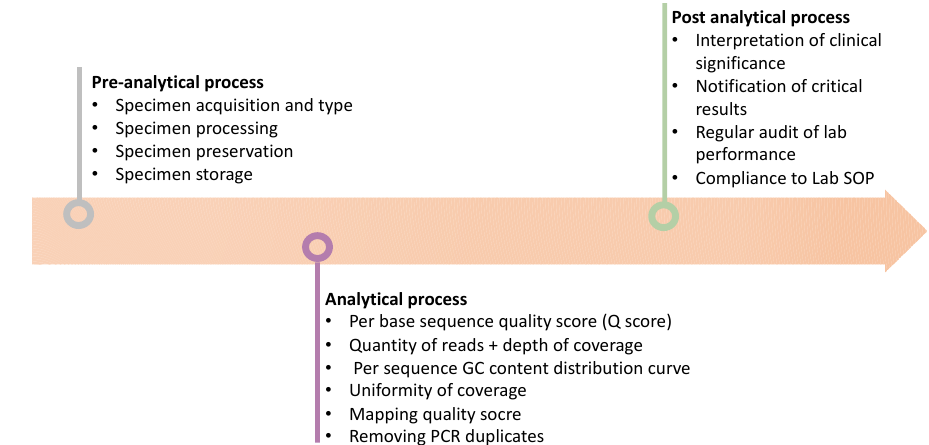
Figure 2. Schematic diagram briefly illustrates the procedure to qualify the NGS results. Firstly, perform the pre-analytical analysis before processing NGS, such as observing the specimen type and preservation etc. Secondly, observe the quality of the NGS results, such as Q score, read depth, and coverage rate etc. Finally, interpretate the NGS results based on the guideline and the clinical indication.